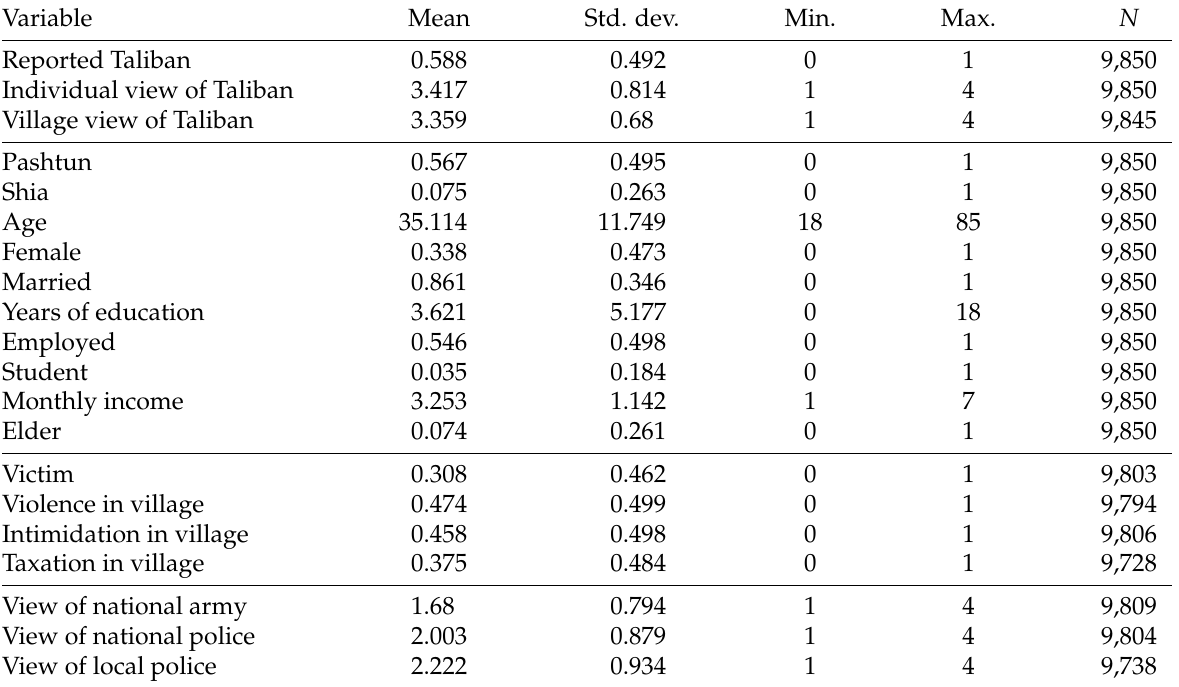
Table 1: Summary statistics